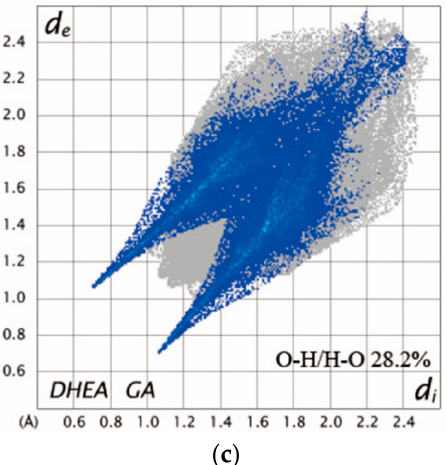
Figure 9. 2D fingerprint plots for ( a ) DHEA, ( b ) DHEA-PHBA, and ( c ) DHEA-GA, showing the contribution of H ··· O/O ··· H interactions.